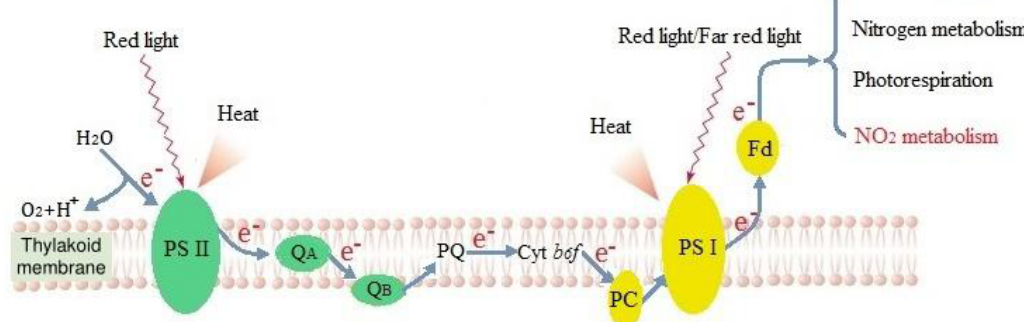
Figure 7. Photosynthetic electron flow distribution. The electrons produced by water splitting in photosynthesis pass through photosystem II (PSII), primary quinone receptor ( Q A ), secondary quinone receptor ( Q B ), plastoquinone (PQ), cytochrome b 6 f (Cyt b 6 f ), plastid blue pigment (PC), and photosystem I (PSI) to ferredoxin (Fd) were assigned to four pathways: CO 2 assimilation, nitrogen metabolism, photorespiration, and NO 2 metabolic pathways (new pathway).